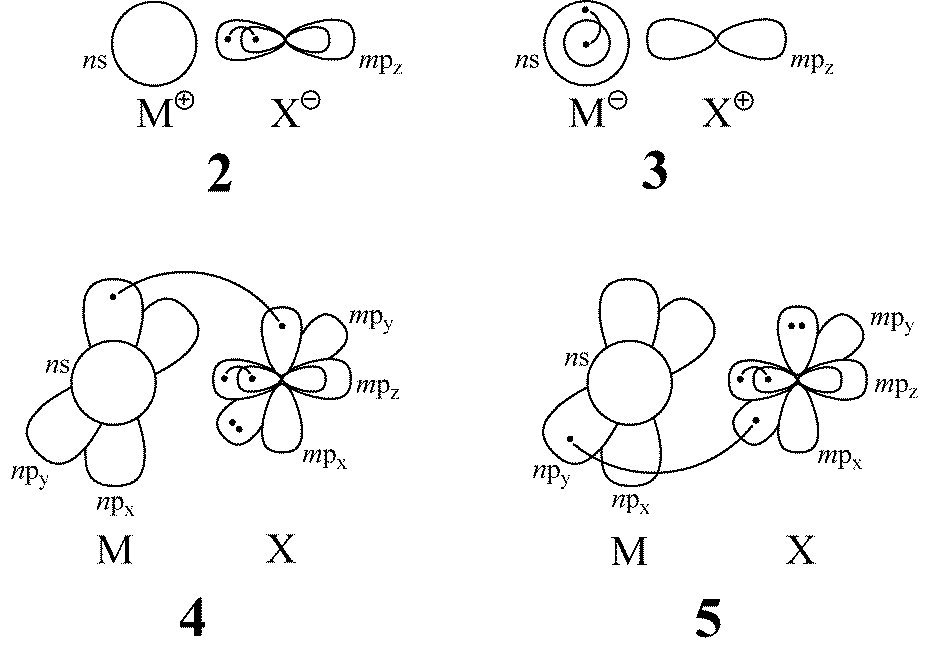
Figure 2. Schematic representation of the “splitting” of the m pz active orbital on X in structures 2 , 4 , and 5 , and of the n s orbital on M in structure 3 in the SD-BOVB level. The dots in these orbitals represent the electrons and the curve connecting the dots indicates a singlet coupling between the two electrons in the two split orbitals (M = Cu, Ag, Au; X = F, Cl, Br).